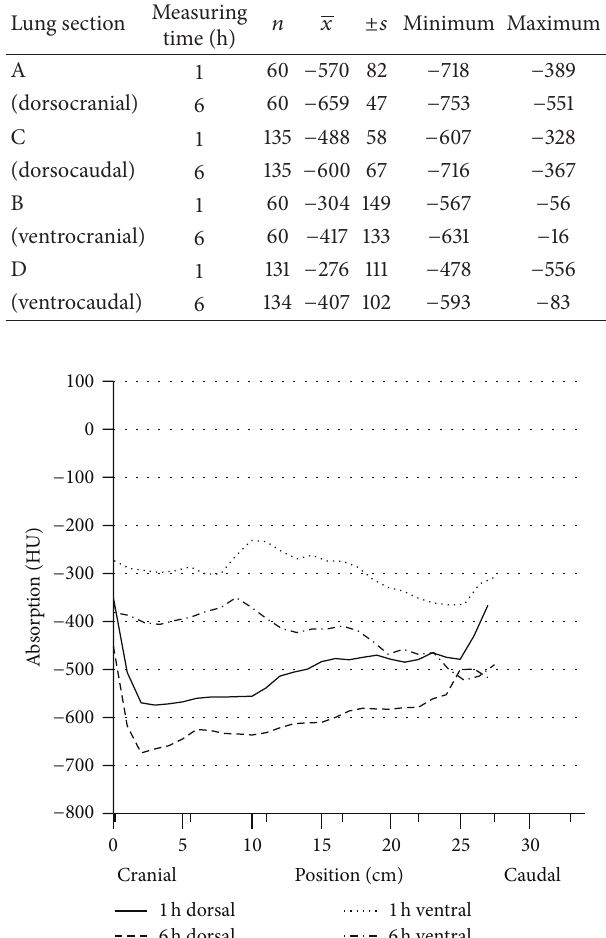
Table 4: Development of X-ray absorption values (HU) in the lung parenchyma of 15 vital calves comparing first and sixth hours of life.